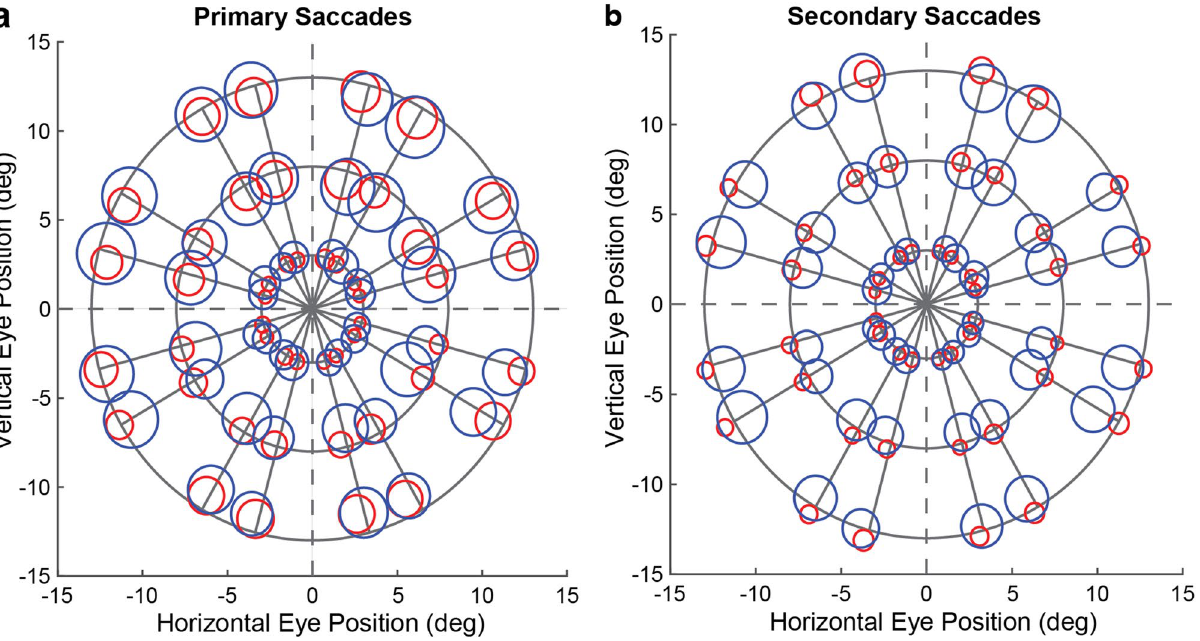
Figure 2. Group averages of systematic and unsystematic errors across space. The blue (MGS) and red (VGS) circles illustrate the average location of and variability in the primary saccade endpoints ( a ) and secondary saccade endpoints ( b ). Target locations are displayed as the intersection of the solid gray lines. The center of each blue/red circle represents the mean saccade endpoint (systematic errors) while the radius represents the saccade endpoint variability (unsystematic errors) averaged across subjects at each target location of Experiment 1. All data figures in the manuscript were generated in MATLAB 54